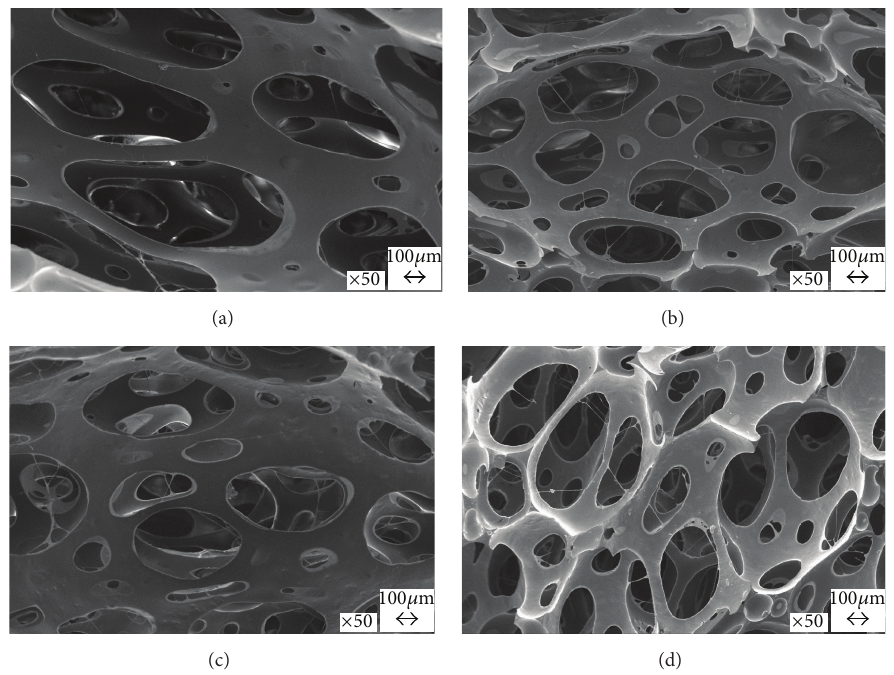
Figure 12: SEM micrographs of (a) neat petroleum PU foam and PU nanocomposite foams with (b) 3 wt% OMMT, (c) 5wt% OMMT and (d) 7wt% OMMT.